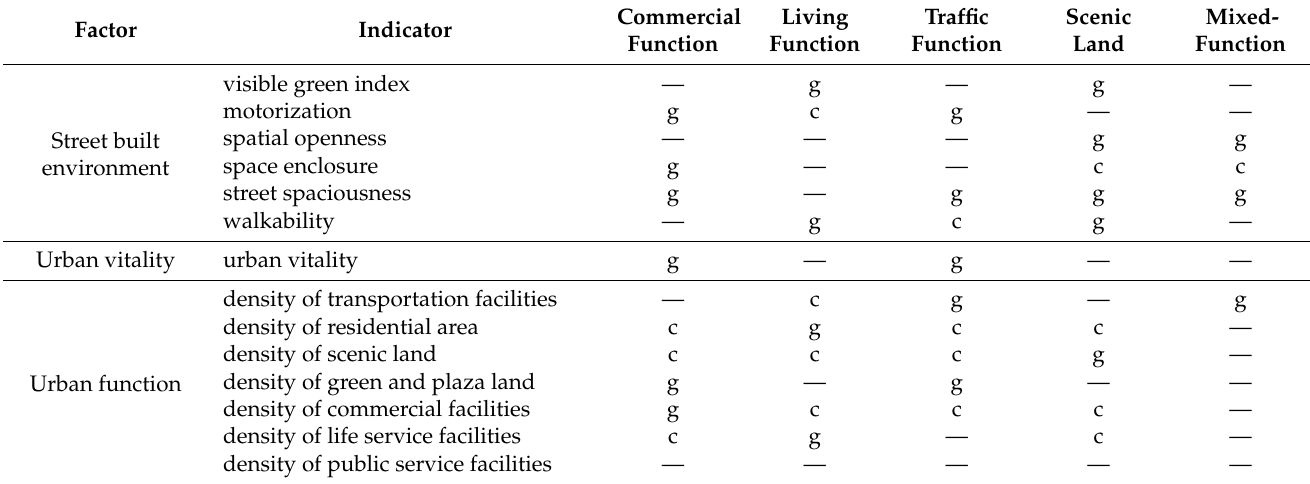
Table 3. Data source and the weight type of selected indicators.